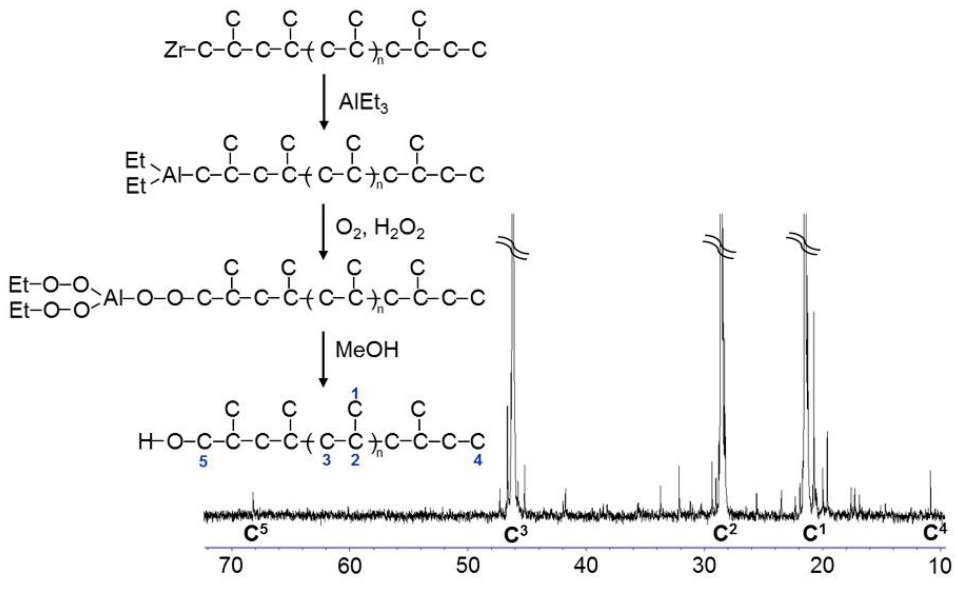
Figure 4. Synthesis scheme and 13 C NMR spectrum of hydroxylated polypropylene (PP-OH).